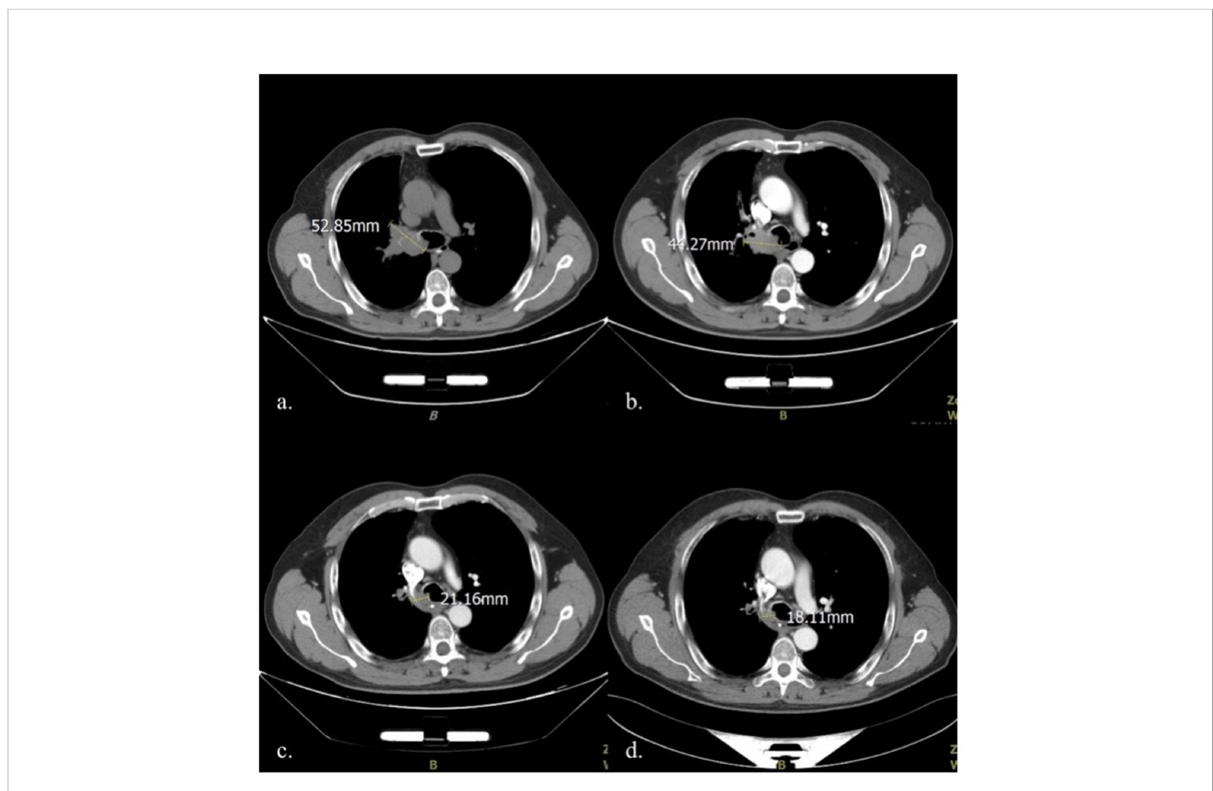
FIGURE 1 Comparison of mediastinal window CT images in four different periods: (A) Before treatment initiation (2020-10-12); (B) . After two cycles of chemotherapy (2020-11-25); (C) At the end of the 5 th fractionation of radiotherapy (2020-12-9); (D) At the end of the 10 th fractionation of radiotherapy (2020-12-16). CT, computed